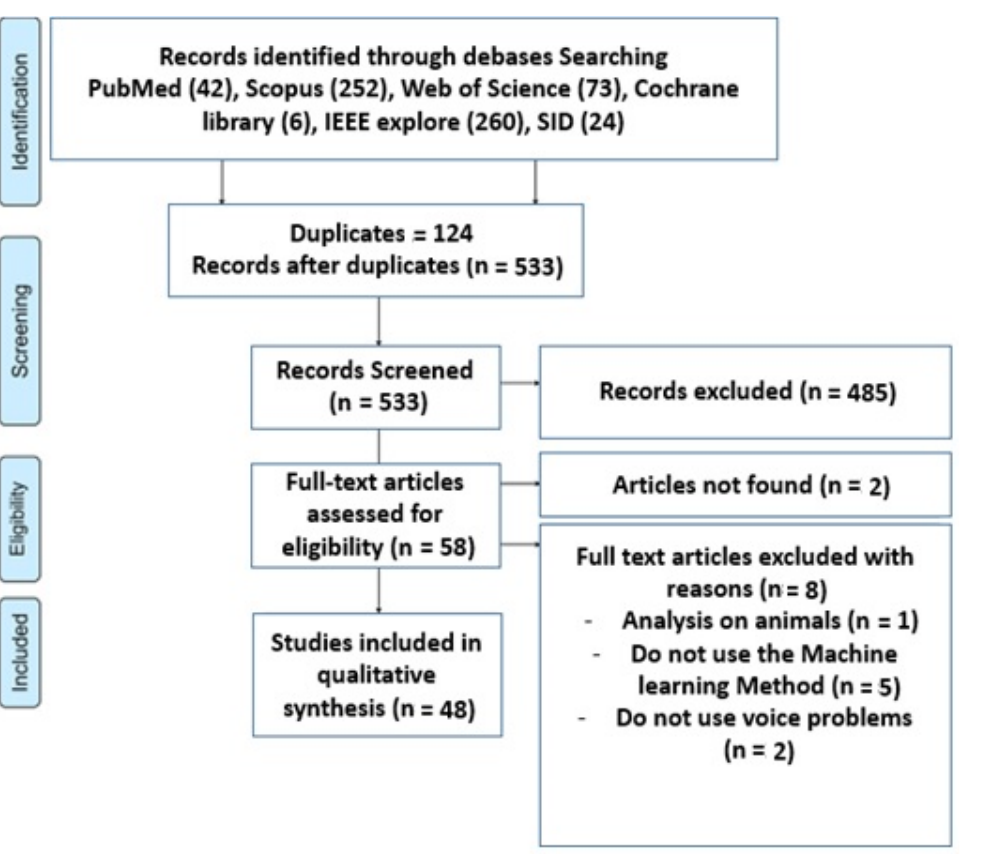
Figure 1. PRISMA flow diagram of study inclusion and exclusion criteria for the systematic review.